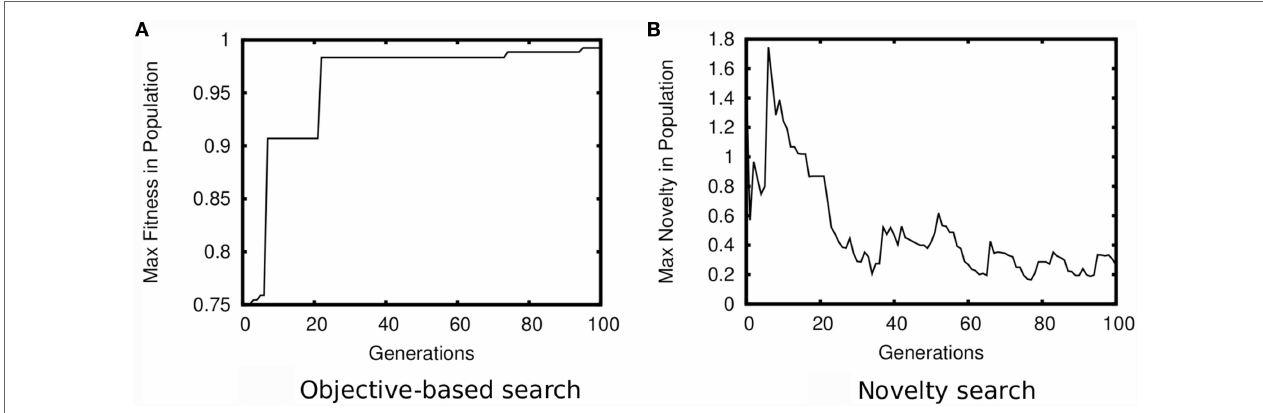
FiGUre 2 | contrast between optimizing absolute and relative measures . Both figures show a plot of the maximum of an optimization measure present in the population over generations. When optimizing a static measure of progress, as in (A) objective-driven search, a high-fitness individual remains so indefinitely. As a result, adaptations quickly sweep through the entire population. Such convergence precludes lineages from distinguishing themselves by producing adaptations at differential rates. In contrast, when optimizing a measure of divergence, as in (B) novelty search, novel innovations cause only a temporary spike in the maximum novelty of the population. In this way, selection can maintain many diverging lineages that can distinguish themselves by more consistently producing novelty than the other ones. Plots are the characteristic result from running search in the medium maze domain of Lehman and Stanley